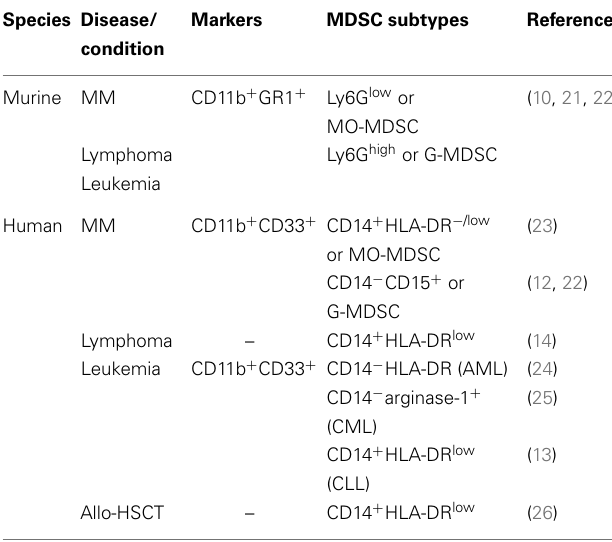
Table 1 | General overview of MDSC phenotype